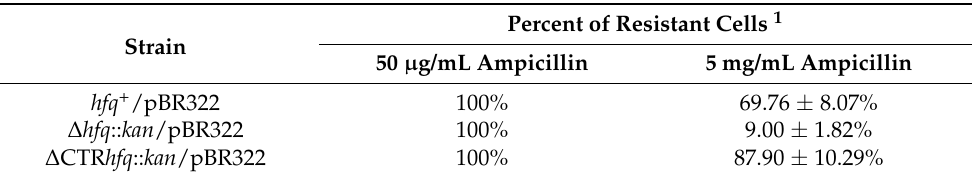
Table 7. Resistance of E. coli hfq +, ∆ hfq :: kan, and ∆ CTR hfq :: kan strains bearing the pBR322 plasmid to different concentrations of ampicillin.